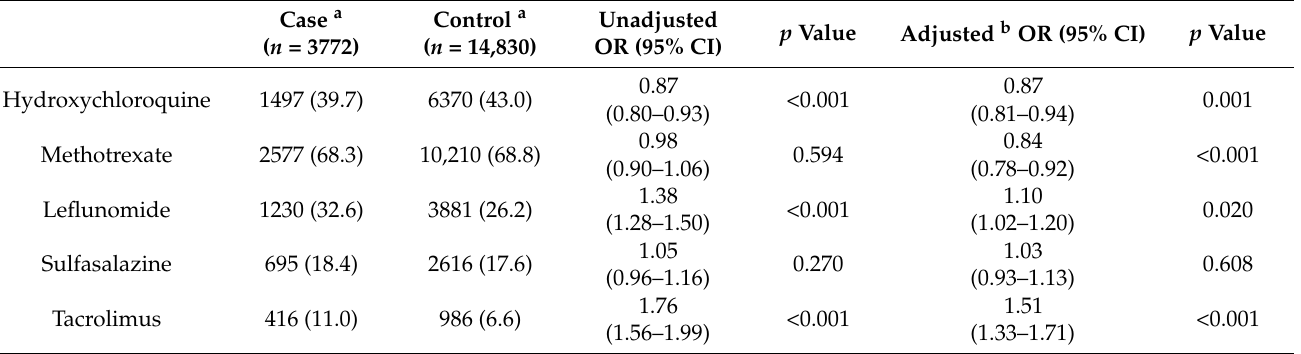
Table 3. Risk of incident DM according to conventional DMARDs use ( ≥ 2 prescriptions within a